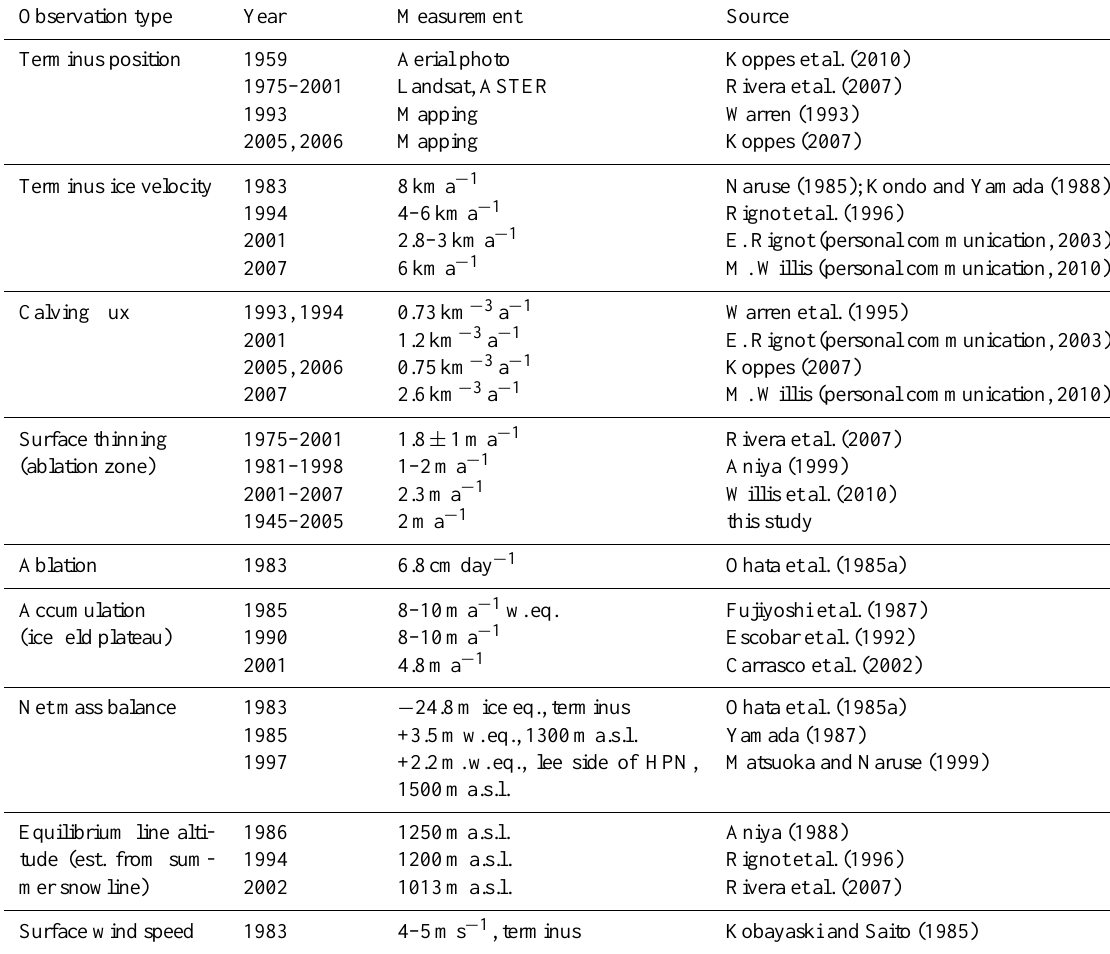
Table 1. Summary of all climate, mass balance, surface and terminus observations made on or near San Rafael Glacier, 1950–2005. Observation